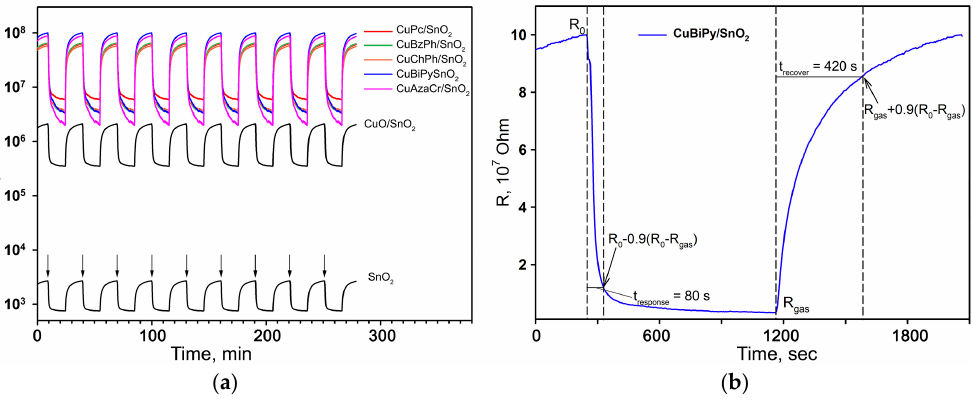
Figure 8. ( a ) The electrical response of different samples to the periodical change of gas phase composition from dry air to 1 ppm H 2 S/air at 200 °C; ( b ) The electrical response (1 cycle) and dynamic characteristics of CuBiPy/SnO 2 hybrid sample.